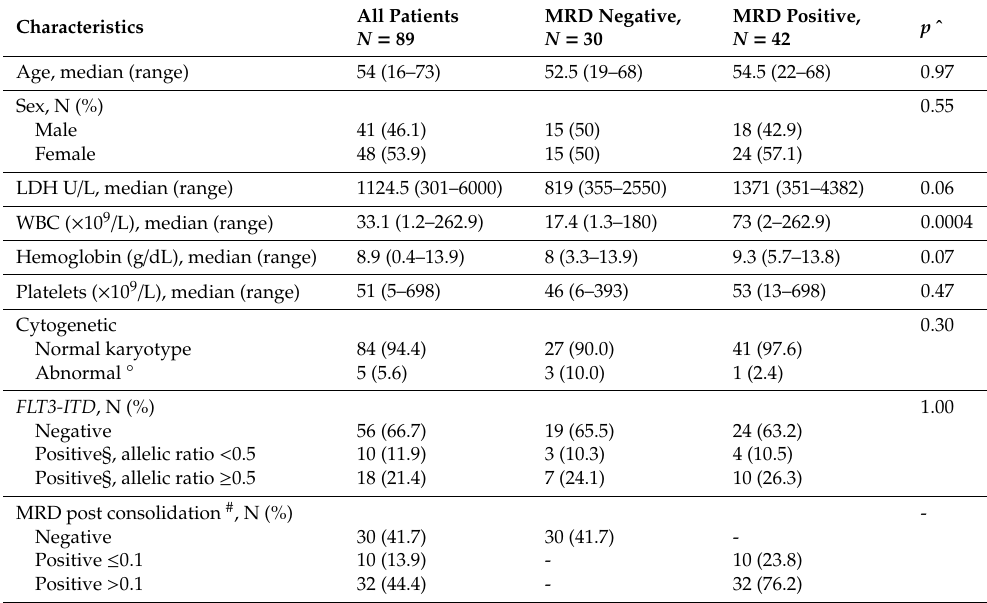
Table 1. Demographic and clinical patients’